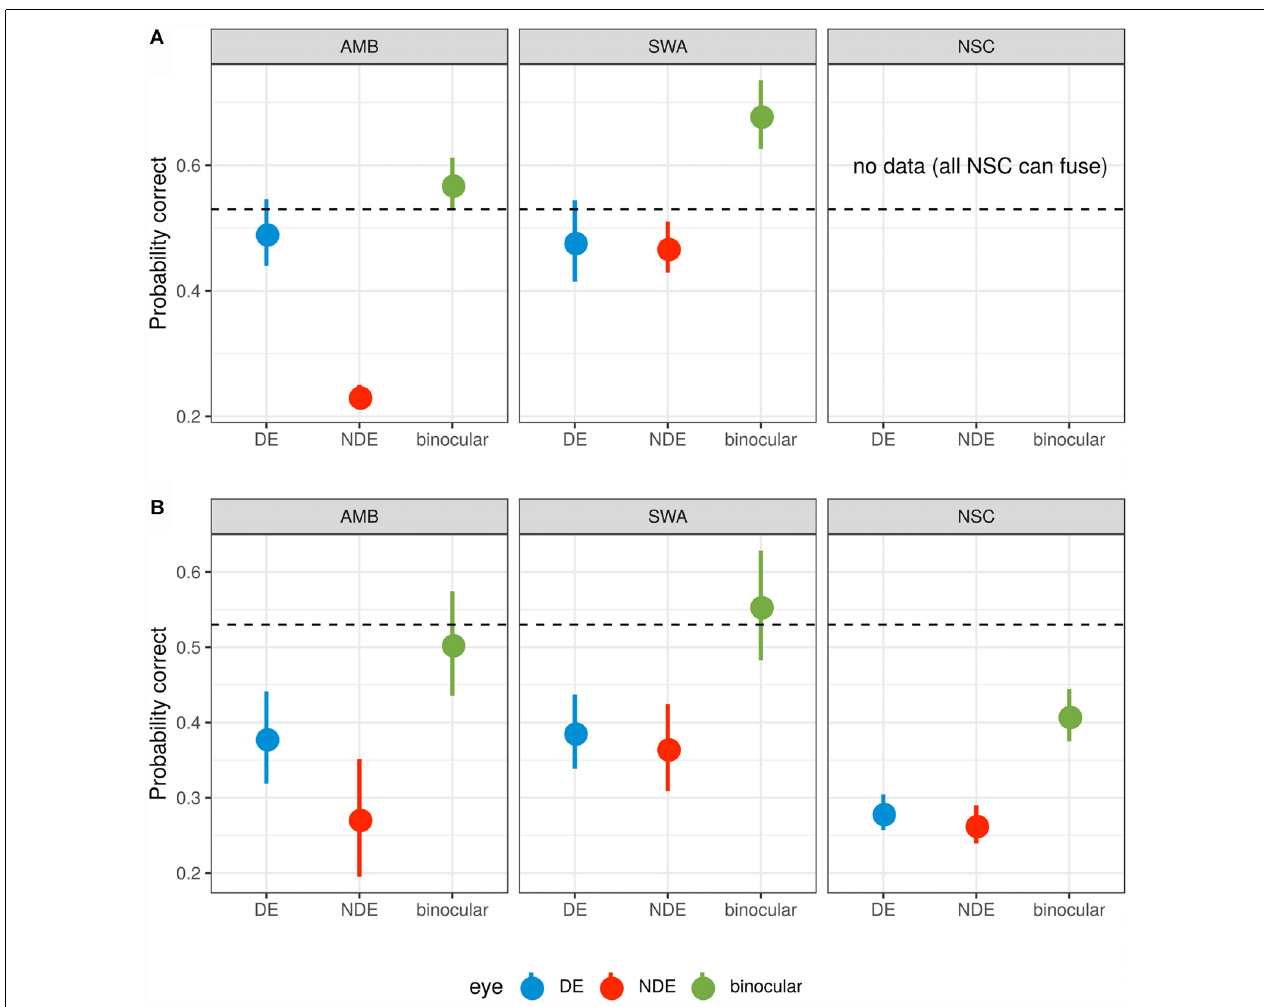
FIGURE 3 | Probability summation. (A) Subjects who were unable to fuse the two monocular images. (B) Subjects who were able to fuse. The dotted line indicates 53% threshold for binocular target identification. For the average contrast needed to reach this binocular threshold, monocular detection probabilities are shown for the non-dominant (red) and the dominant (blue) eye. Based on probabilistic summation of each eye’s target detection probability, the expected probability for the binocular condition is shown in green. A value below the dotted line indicates that actual binocular summation exceeds probabilistic summation. A value above the dotted line indicates that the monocular images inhibit one another so that performance is worse than expected from target detection by independent monocular mechanisms. Error bars represent ± 1 SEM.